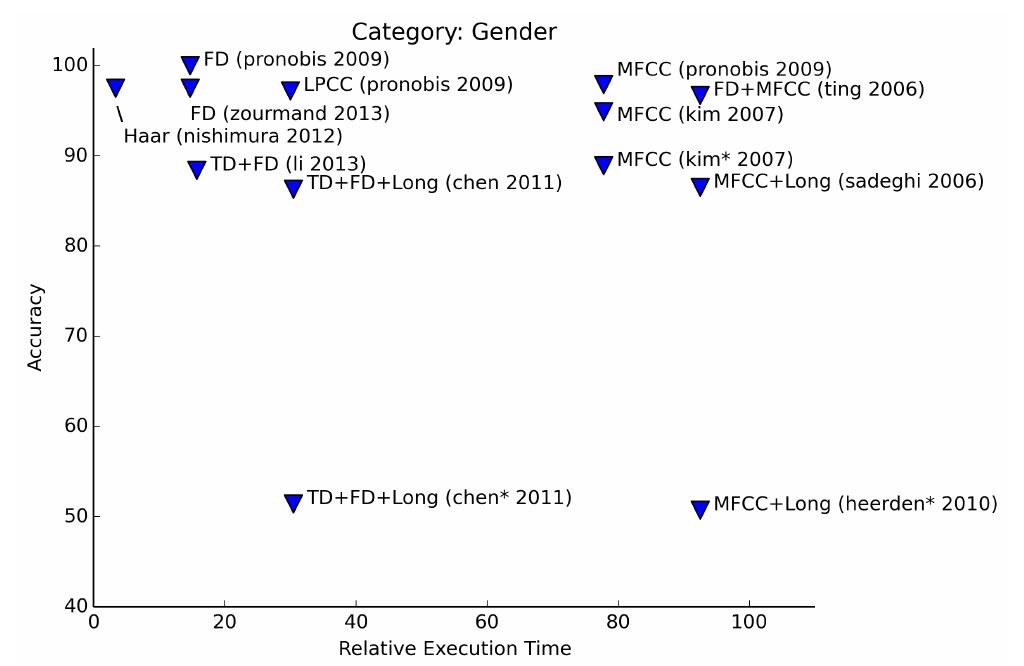
Figure 7. Relative execution time for gender